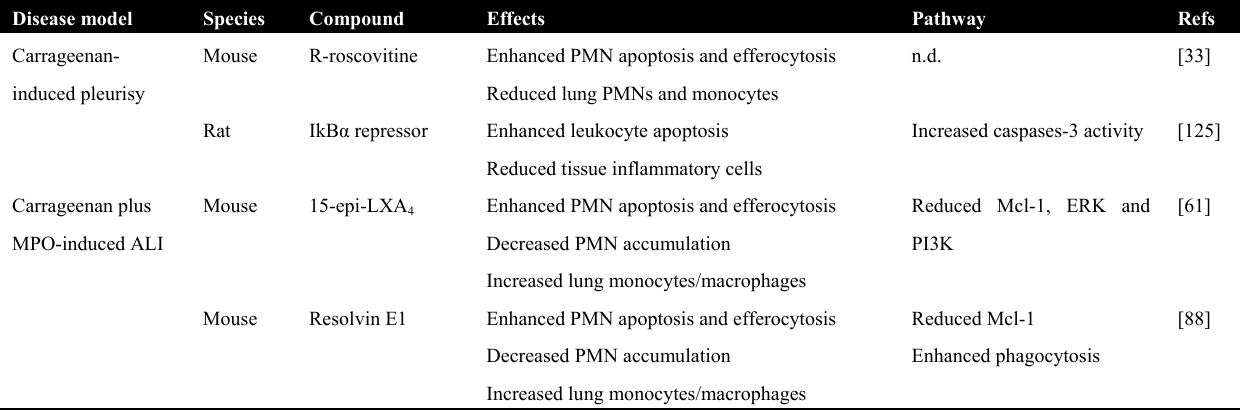
Table 1. Summary of therapeutic strategies to induce neutrophils apoptosis for enhancing the resolution of inflammation in experimental models of inflammation (ALI, acute lung injury; TRAIL, TNF-related apoptosis-inducing ligand; DRB,